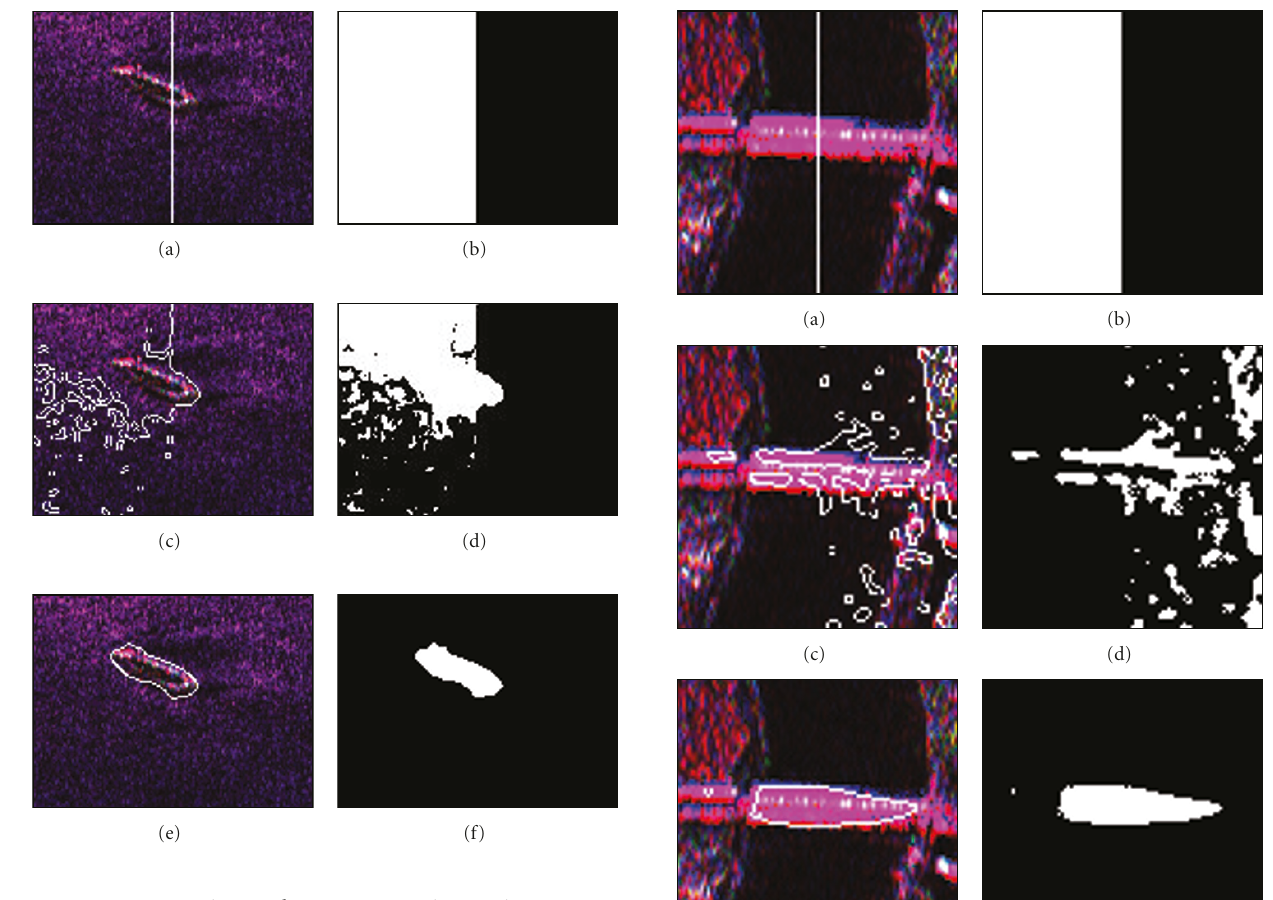
Figure 4: Segmentation result on an AIRSAR image, size: 101 × 133, α = 3, μ = 20 . 2. Left column: PolSAR image and the contours. Right column: corresponding object segmentation results. (a) and (b) Initial; (c) and (d) after 100 iterations; (e) and (f) converged state after 350 iterations.